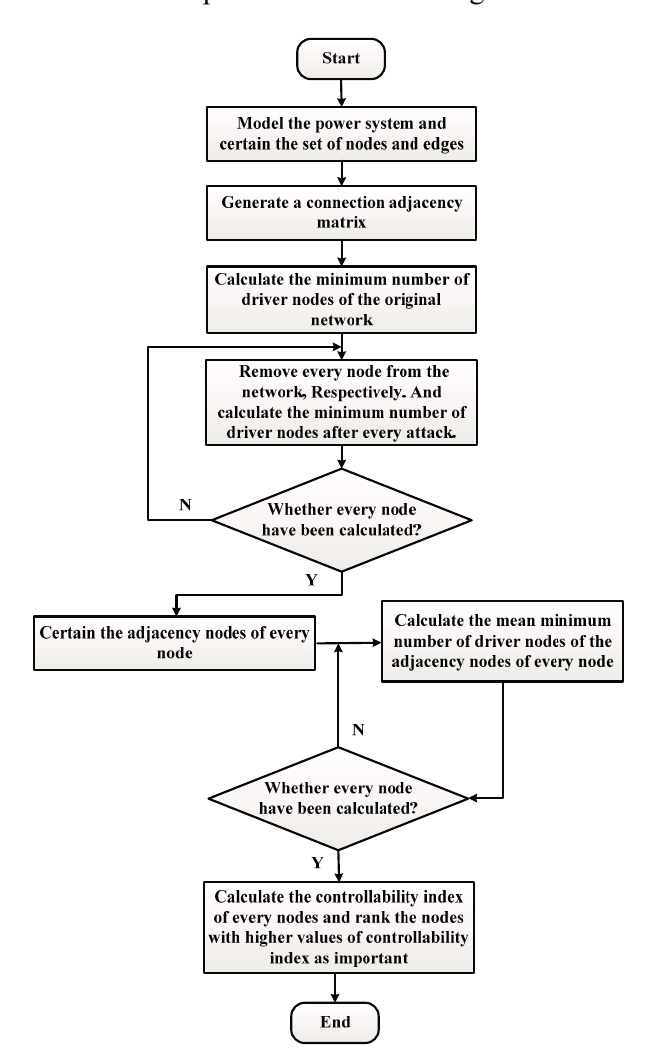
Figure 2. Identification process based on network controllability